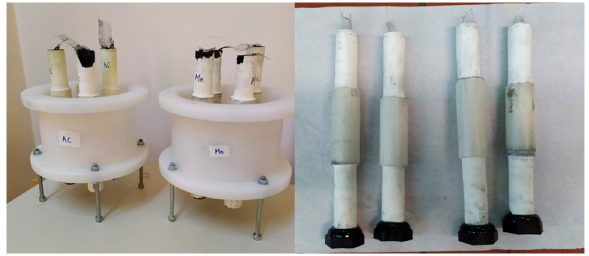
Figure 2. Ceramic electrodes produced.